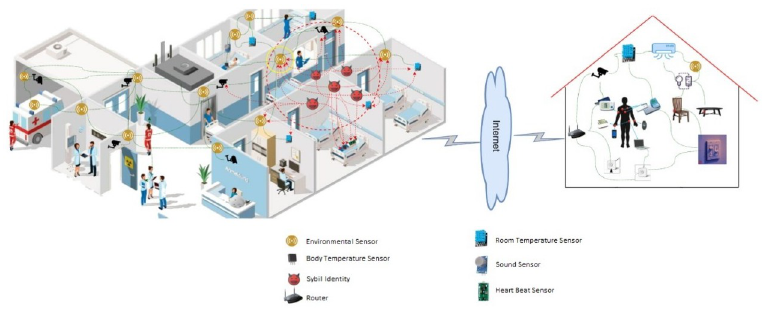
Fig 10. Block diagram of proposed